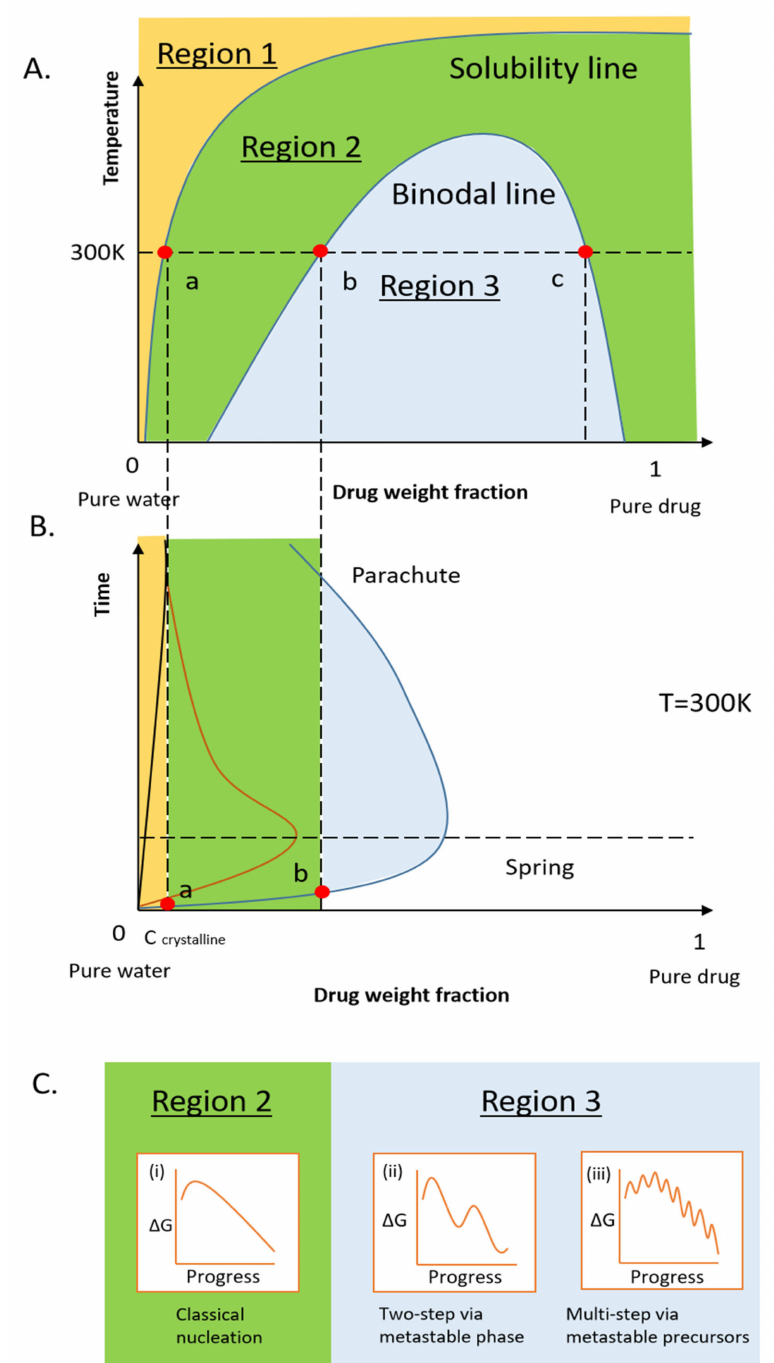
Figure 1. ( A ) Schematic temperature-composition phase diagram of the drug-water binary system, ( B ) the schematic dissolution diagram of a crystalline drug (the black solid curve), pure amorphous drug “spring” (the brown solid curve) and ASD formulation “spring and parachute” (the blue solid curve). ( C ) Gibbs free energy landscapes of dissolved drug molecules forming a stable bulk crystal through (i) classical nucleation and growth pathway, (ii) the two-step pathway via the metastable drug-rich liquid phase, and (iii) the aggregation of thermodynamically metastable particles and possible pathways [64]. Point a is the intersection of the solubility line and the horizontal temperature line, which reflects drug crystalline solubility at this temperature. Points b and c are intersections of the binodal line, indicating the drug and water weight fraction in drug-rich phases and drug-lean